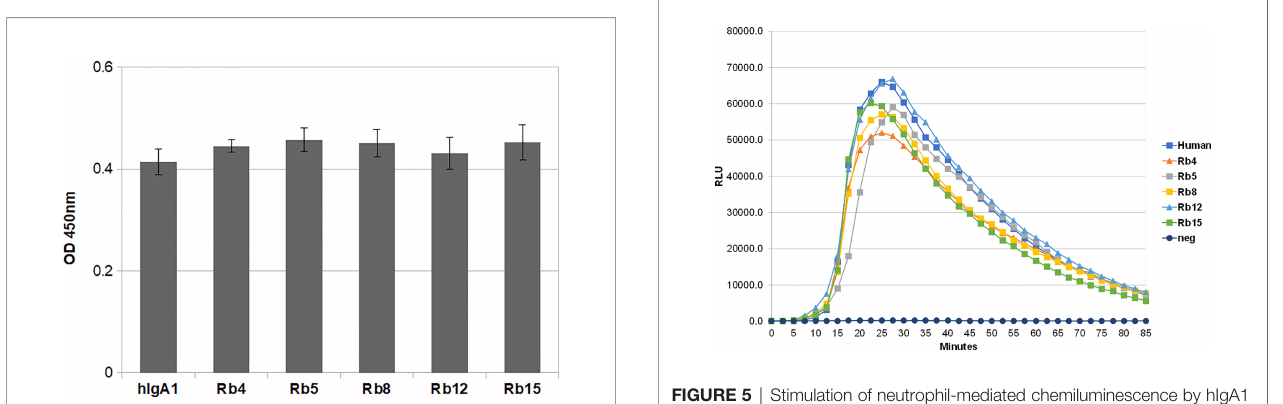
FIGURE 3 | NIP binding ELISA using 0.1 m g/mL of each immunoglobulin. The plate was probed with an HRP-conjugated anti-mouse l light chain antibody. Shown is the mean of triplicate measurements with standard deviation errors. Signi fi cance was determined by one-way ANOVA and Tukey ’ s multiple comparisons test (signi fi cant difference among means for p<0.05).